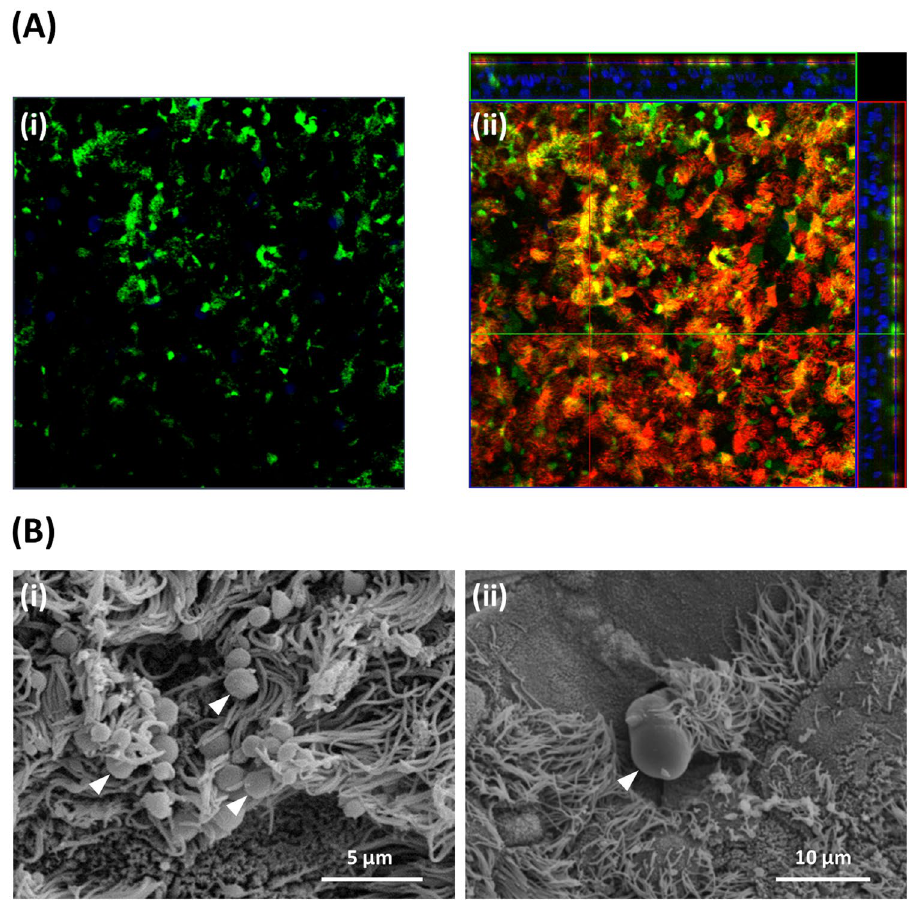
assess mucus production and identify goblet cells using ( A ) immunofluorescence microscopy and ( B ) SEM. In ( A ) standard immunofluorescence imaging shows mucus and its association with goblet cells (i) (mucus [Muc5AC] - green; nuclei – blue); Z-stack orthogonal representation highlights surface-localisation of mucus (ii) (mucus [Muc5AC] - green; cilia - red; nuclei - blue). In ( B ) SEM revealed the presence of numerous globules of mucus and their close association with cilia ([i], arrowheads) and identified goblet cells in the act of extruding mucus ([ii],